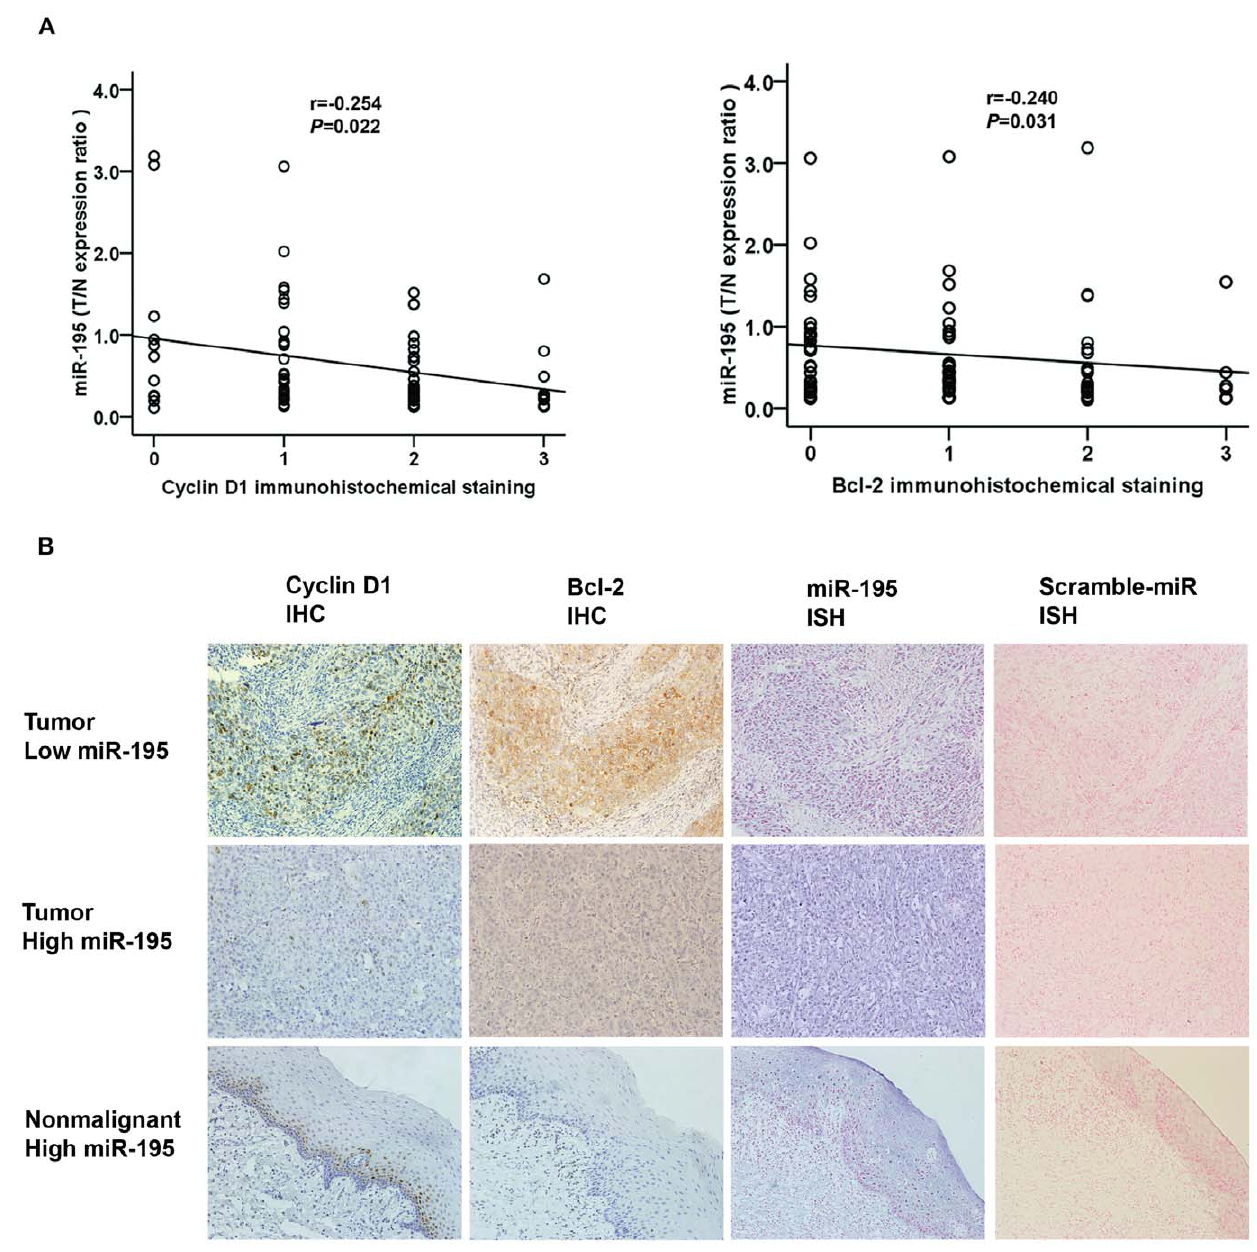
Figure 3. Inverse correlation between miR-195 and Cyclin D1 or Bcl-2 protein levels in TSCC. Expression of Cyclin D1 and Bcl-2 was examined by immunohistochemistry (IHC) and miR-195 expression was detected by qRT–PCR and in situ hybridization (ISH). (A), Statistical analysis of the expression of miR-195 in tumor vs nonmalignant tissue. Spearman’s rank correlation analysis was performed, with r and P values as indicated. (B), The concurrence of miR-195 expression and corresponding variation of Cyclin D1 and Bcl-2 was confirmed in human TSCC and nonmalignant specimens by ISH with miR-195 detection probe or Scramble-miR and IHC (200 6 magnification).